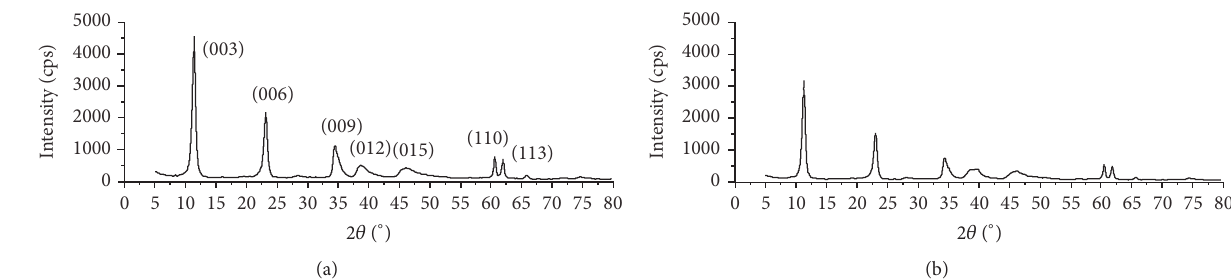
Figure 1: XRD patterns for the hydrothermally treated layered double hydroxide (HT-LDH) before (a) and after (b) palladium incorporation.